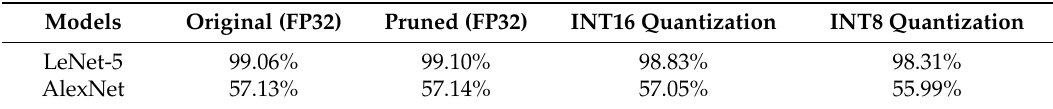
Table 3. Inference accuracy between different precisions.